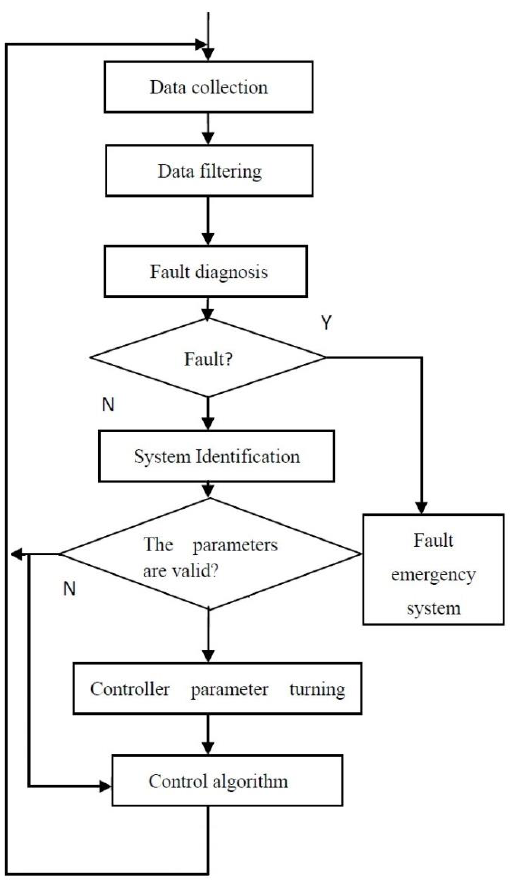
Figure 6. Flow chart of adaptive control system.